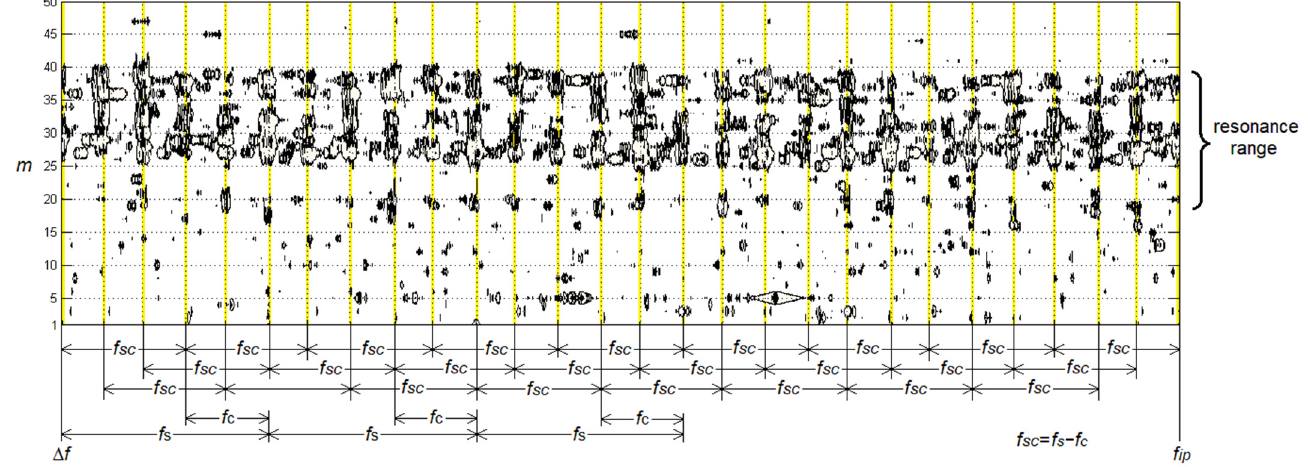
Figure 9. F-F image of the frequency spectrum of the vibration acceleration of the motor’s outer casing with a damaged bearing cage ( f P = f ip ). casing with a damaged bearing cage ( f P = f ip